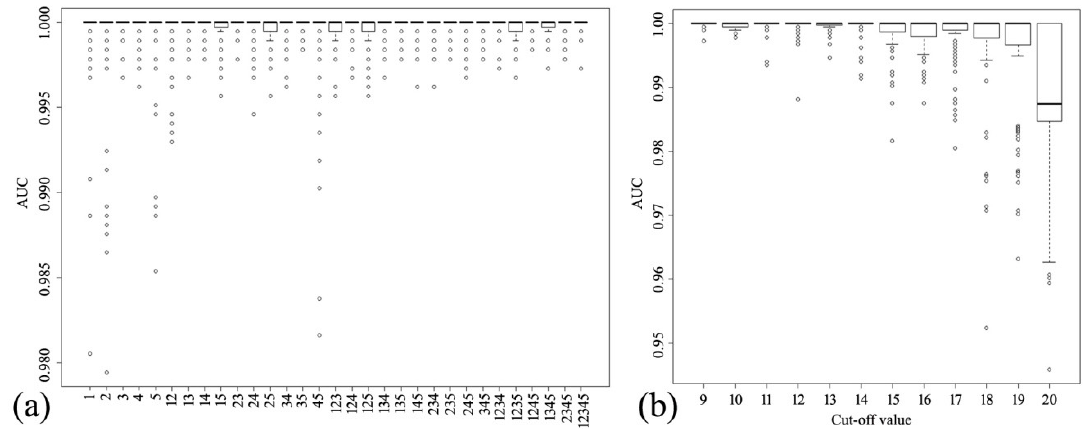
Figure 2. Contributions of AA factors and different mutation sets. ( a ) Performance of SVM classifier for different combinations of the five AA factors. The x and y coordinates denote the 31 combination patterns and the AUC values (from 0 to 1), respectively. Along the x axis, ‘13’ denotes that the set of 183 amino acid residues was transformed using AA Factor 1 and AA Factor 3 together, for example. ( b ) Contributions of mutation positions for different cutoff values (range 9–20). The y coordinate shows the AUC values.